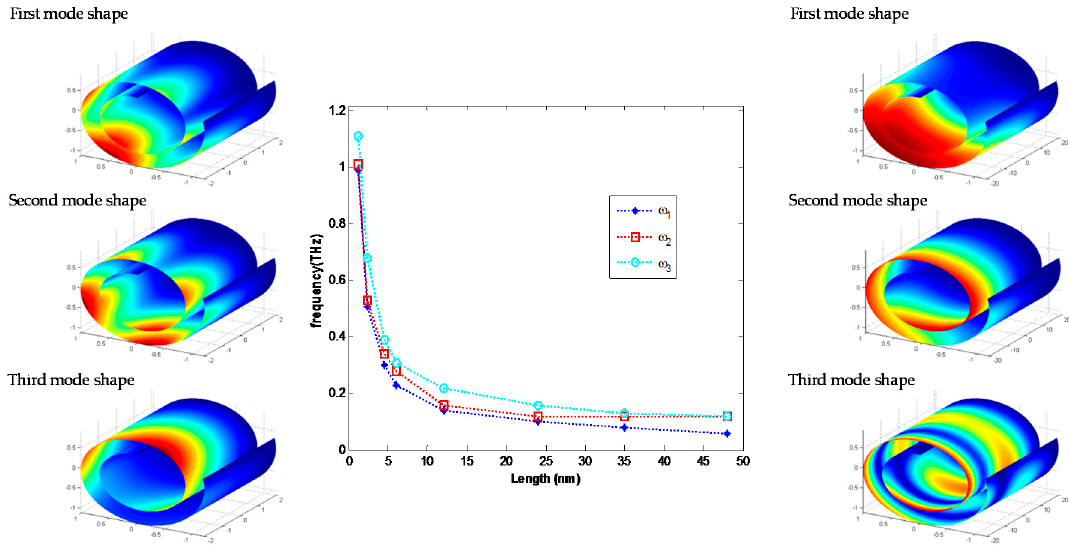
Figure 6. Variation of first three natural frequencies versus length of CNS with FCSS boundary condition.